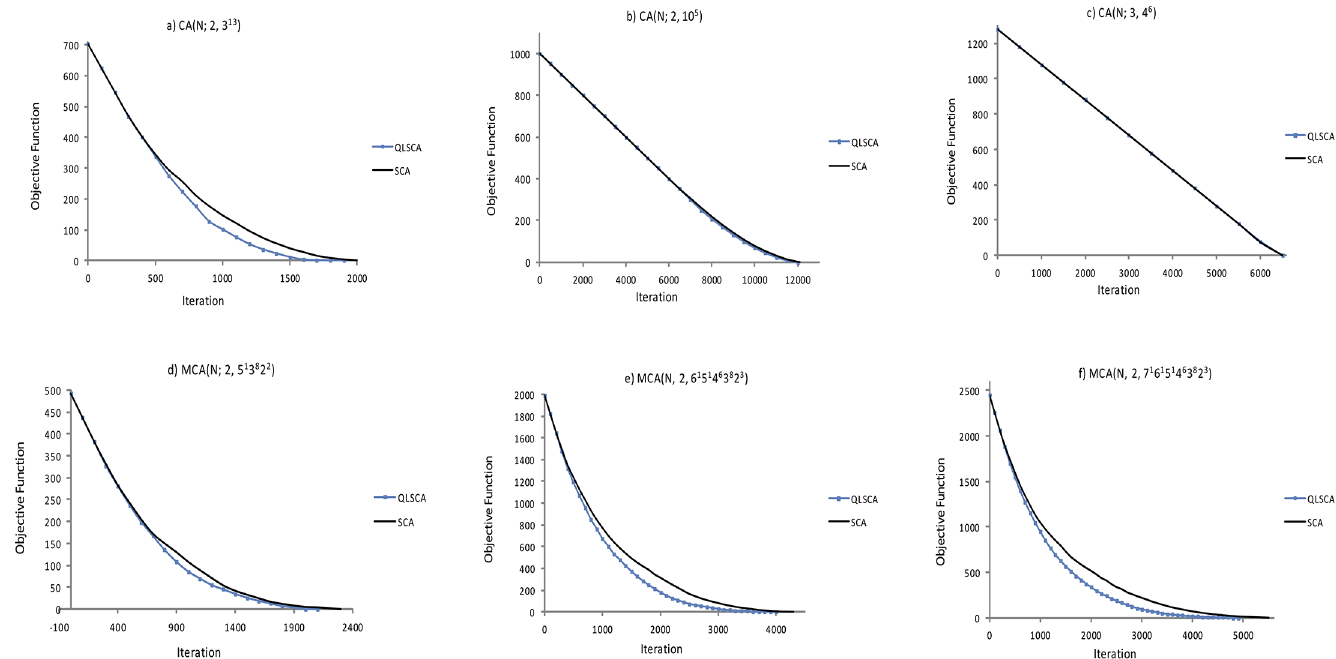
Fig 9. Convergence patterns for Table 3.